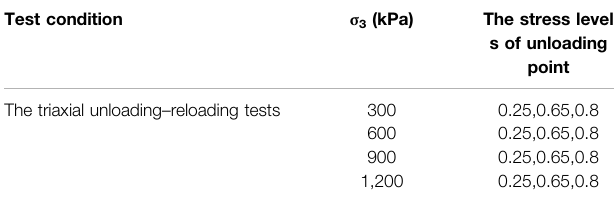
TABLE 2 | Multistage unloading – reloading sequences in the triaxial tests of LCSG materials with cement contents of 20, 60, and 100 kg/m 3 . Test condition σ 3 (kPa)